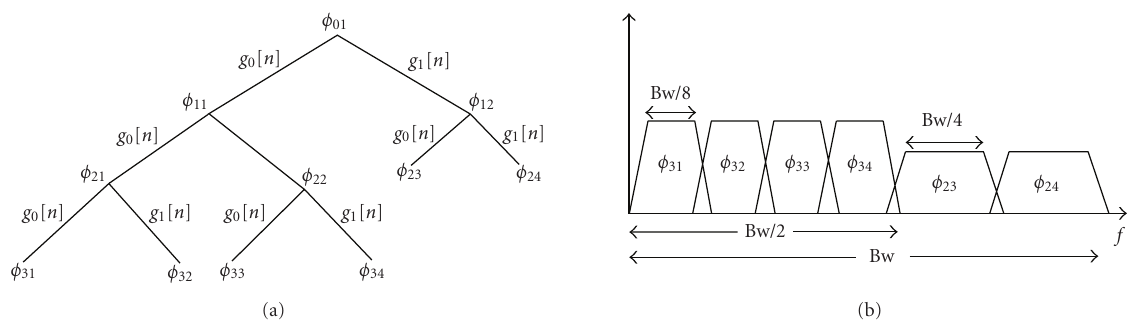
Figure 3: (a) WPDM tree structure suitable for broadcasting heterogeneous services. (b) Symbolic subband structure of the system in